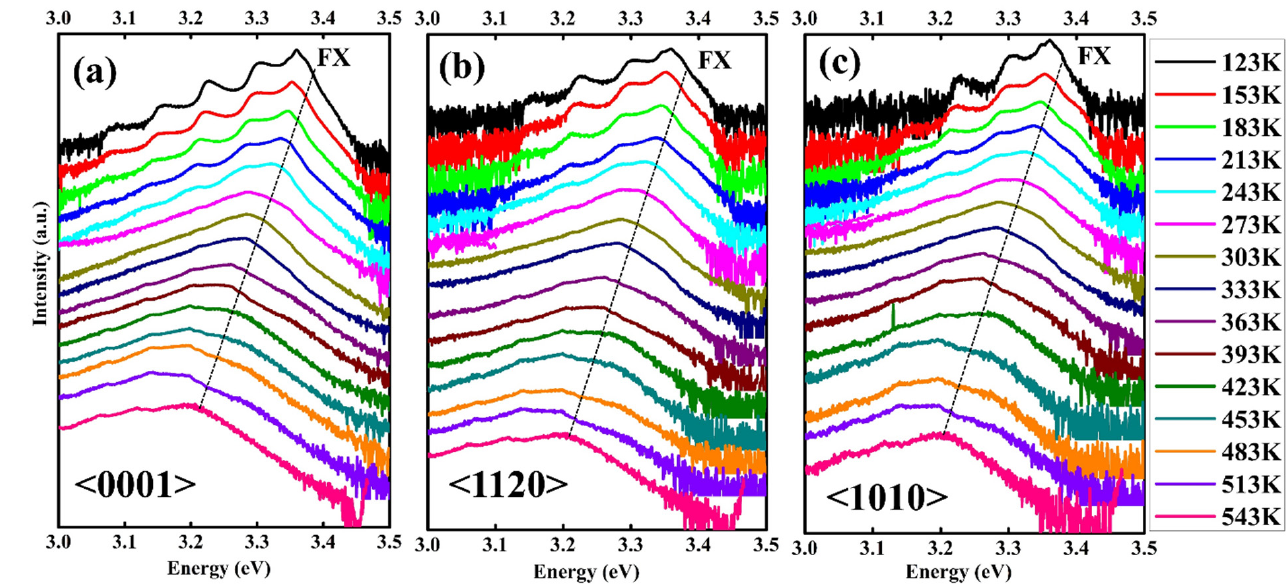
Figure 8. Temperature-dependent near-band-edge emission PL spectra of ZnO Single crystals with ( a ) <0001> ( b ) <1120> and ( c ) <1010> orientation measured over the temperature range 123–543 K using 320 nm excitation laser. The free-exciton (FX) transition dominates at elevated temperature. Here, E g represents the bandgap energy, E A and E D are acceptor and donor binding energies, respectively, ε is the dielectric constant, and “ r ” is the distance between acceptor and donor. While increasing the temperature, the carriers on the DAP site with smaller distance are released into the band and as a result, the line is shifted toward low